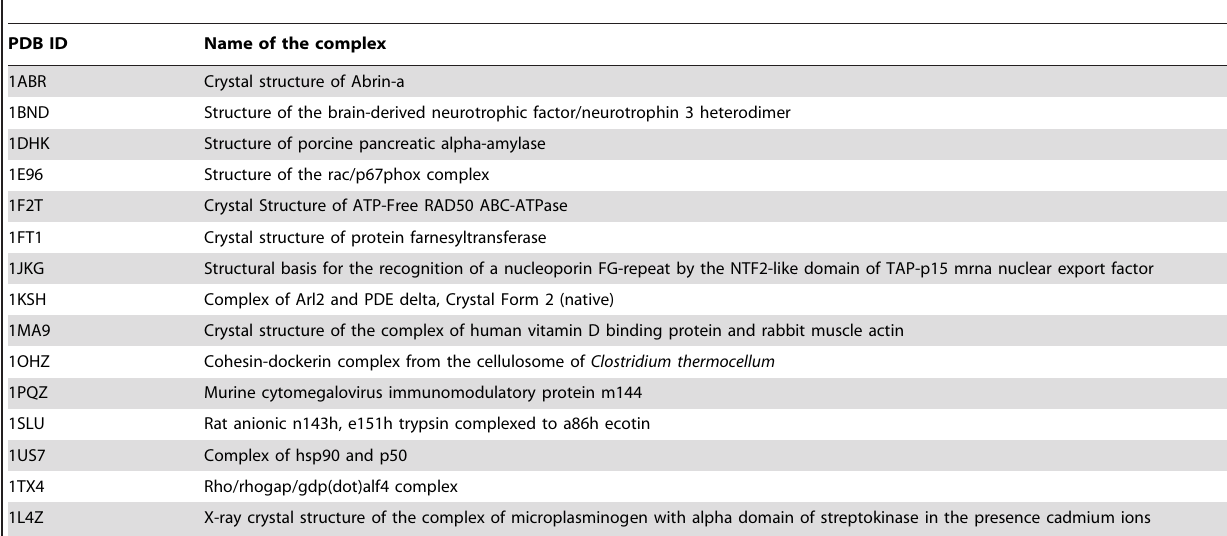
Table 2. List of 15 heterodimers (chain A and B) used for training DockScore.